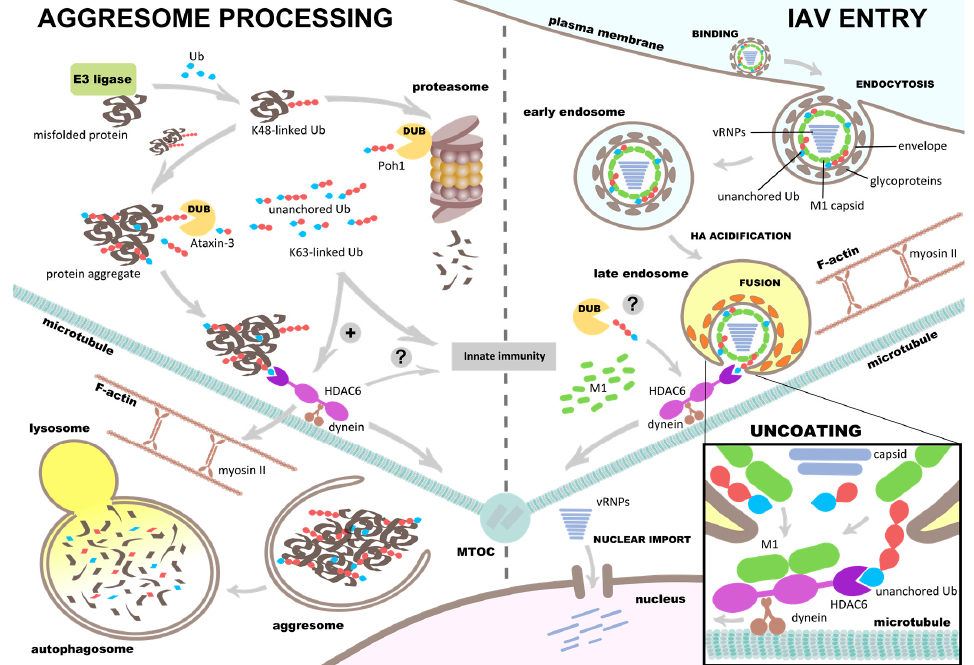
Figure 3. HDAC6 and unanchored ubiquitin promote aggresome processing and influenza A virus (IAV) uncoating. Left side : HDAC6 regulates the aggresome processing machinery. E3 ubiquitin ligases polyubiquitinate misfolded proteins, and those with a tetra K48-linked ubiquitin chain or longer are degraded by the proteasome [78]. Proteasome inhibition leads to formation of large, misfolded protein aggregates with polyubiquitinated chains, which are cleaved into unanchored ubiquitin chains by DUBs such as Ataxin-3. The C-terminus of ubiquitin is exposed on the unanchored ubiquitin chains and bind to HDAC6 ZnF-UBP. This, by yet unknown mechanisms, activates dynein binding of HDAC6 via its linker region between CD1 and CD2. The unanchored ubiquitin chain(s) is now linked to the dynein motor and microtubules, allowing retrograde transport of the protein aggregate toward the microtubule-organizing center (MTOC) ( aggresome formation ). Misfolded aggregates that are sequestered to the MTOC eventually form a large complex called the aggresome. HDAC6 promotes autophagy, which involves the actin network, myosin II, and Poh1, a proteasome-associated DUB. Poh1 generates K63-linked unanchored ubiquitin chains that activate HDAC6 ( aggresome clearance ) [12]. The red ubiquitin (Ub) depicts ubiquitin that is anchored, the blue ubiquitin depicts unanchored ubiquitin with a free C-terminus; Right side : IAV hijacks the aggresome processing machinery during host cell entry. After binding to the cell surface, IAV internalizes by endocytosis, travels to late endosomes (LEs) in the vicinity of the MTOC. In LEs the low pH (5.5–5.0) triggers hemagglutinin (HA) acidification and fusion of the viral envelope with the limiting endosomal membrane. The fusion pore exposes the viral core containing unanchored ubiquitin chains to the cytosol, which recruit HDAC6 and activate the aggresome processing machinery. HDAC6 binds to matrix protein M1, dynein, and myosin, and promotes capsid disassembly by the shearing force of the cytoskeletal motors ( box; uncoating ). M1 becomes dispersed in the cytosol, the viral ribonucleoproteins (vRNPs) penetrate into the cytosol and are imported into the nucleus through nuclear pore complexes by importin α / β [52,66]. Unanchored ubiquitin carried by IAV might activate HDAC6 similar to aggresome processing [12]. HDAC6, unanchored ubiquitin chains are implicated in retinoic acid-inducible gene 1 (RIG-I) immune signaling and NACHT, LRR and PYD domains-containing protein 3 (NLRP3) inflammasome regulation